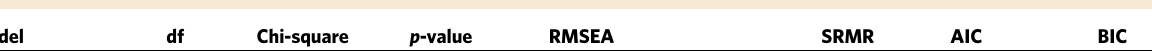
Table 1 Model fi ts for the two measurement models.